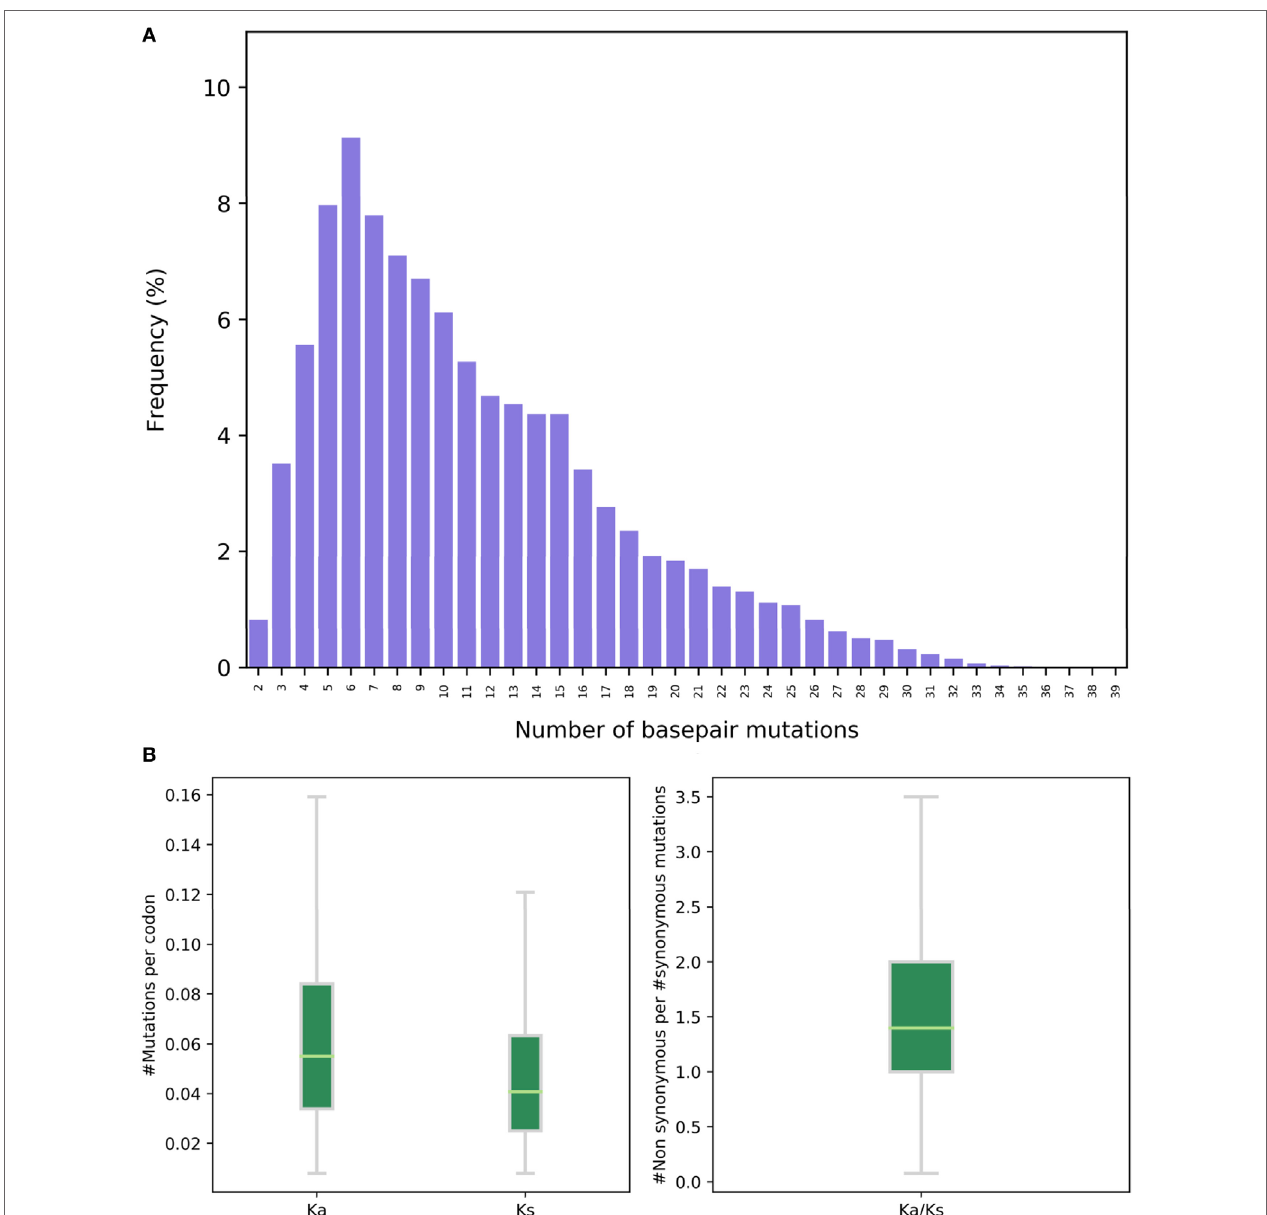
FIguRe 4 | Somatic hypermutation analysis. (A) A histogram showing the frequency of the number of base pair mutations in a next-generation sequencing replicate. The X axis represents the number of mutations (both synonymous and non-synonymous) defined by comparison to the germline genes. (B) The number of non-synonymous (Ka) and synonymous (Ks) mutations and their ratios (Ka/Ks), based on comparison to the germline genes. The Y axis is the number of mutations per codon. Each dot represents a unique variable region nucleotide